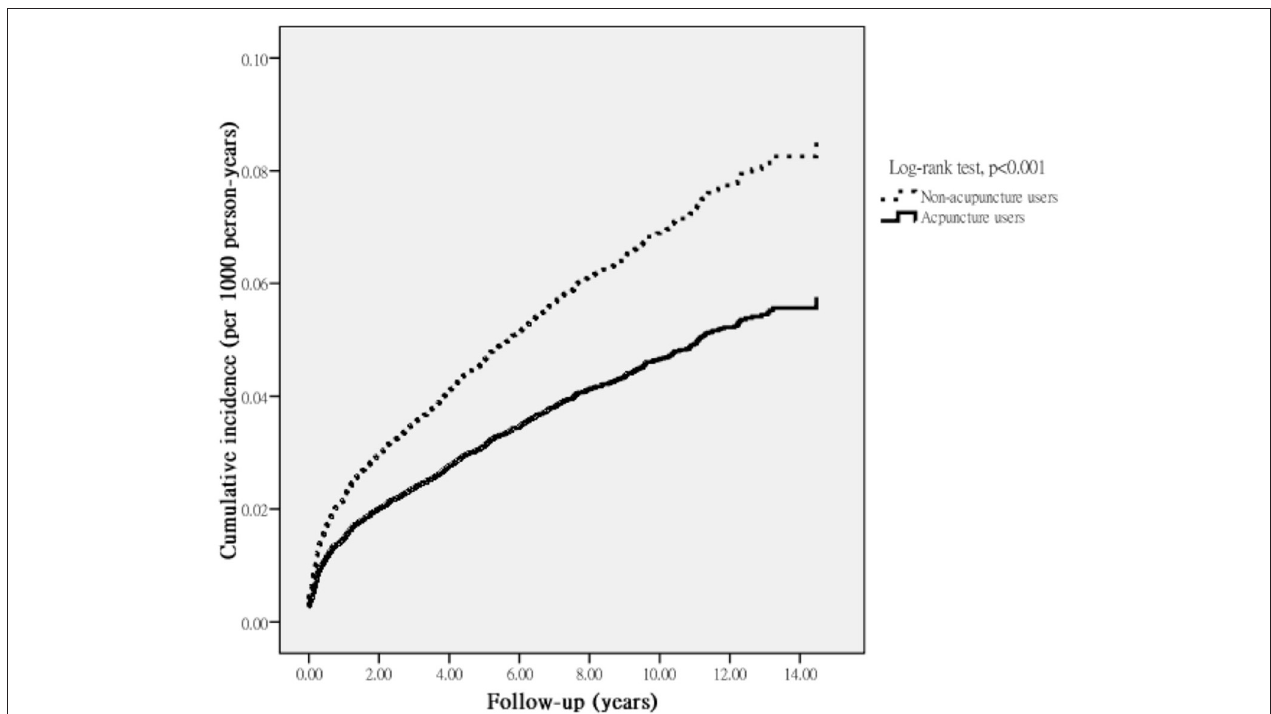
FIGURE 2 | Cumulative incidence of T2DM among RA patients who received or did not receive